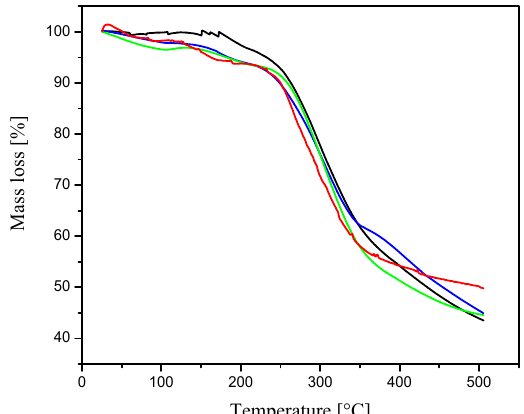
Figure 4. TGA thermograms of electrospun nanofibers: SFs (black line), CSFs (blue line), CSFs / 15%DSS (green line), and CSFs / 30%DSS (red line).